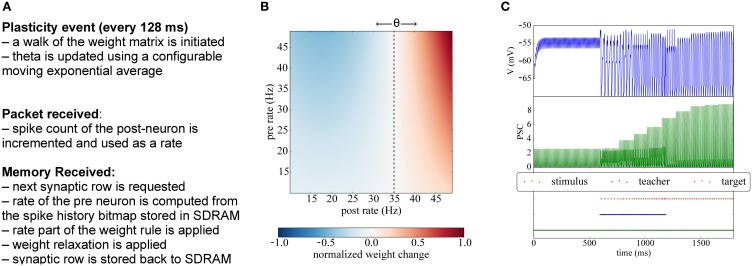
Implementation of BCM plasticity. (A) Algorithm for BCM learning on the plasticity core. (B) Illustration of the BCM rule: normalized weight change as a function of the pre- and post-rates, with θ = 35 Hz. (C) Potentiation experiment using a teaching signal: when stimulation is paired with a teacher signal that forces the post-synaptic neurons in the target population to fire, the weights get potentiated and become strong enough to drive the post-synaptic neuron.